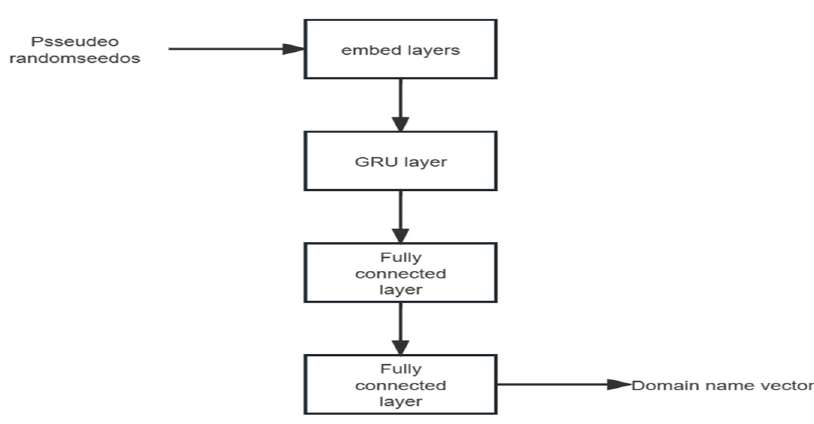
Figure 3. Generator design.